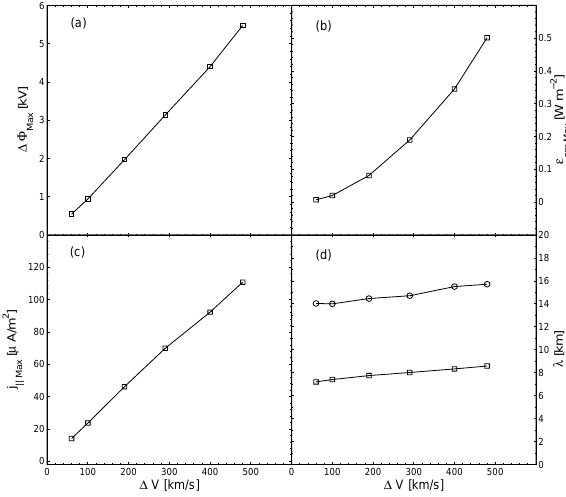
Fig. 5. Variation of arc characteristics as a function of the bulk ve- locity at the LLBL side of the TD: (a) the variation of the maximum of the field-aligned potential drop; (b) the variation of the maximum of the flux of precipitating energy; (c) the variation of the maximum field-aligned current density; (d) the width at half maximum of the current sheet (circles) and of the auroral arc